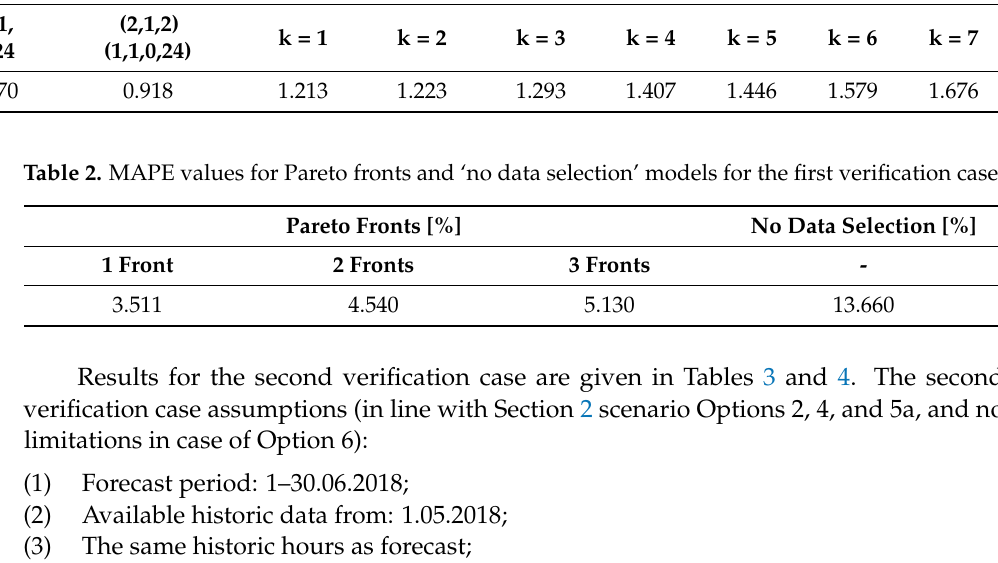
Table 1. MAPE values for naïve approach, SARIMAX model, and kNN algorithm for the first verification case. Naïve Approach [%] SARIMAX [%] kNN [%] h-1